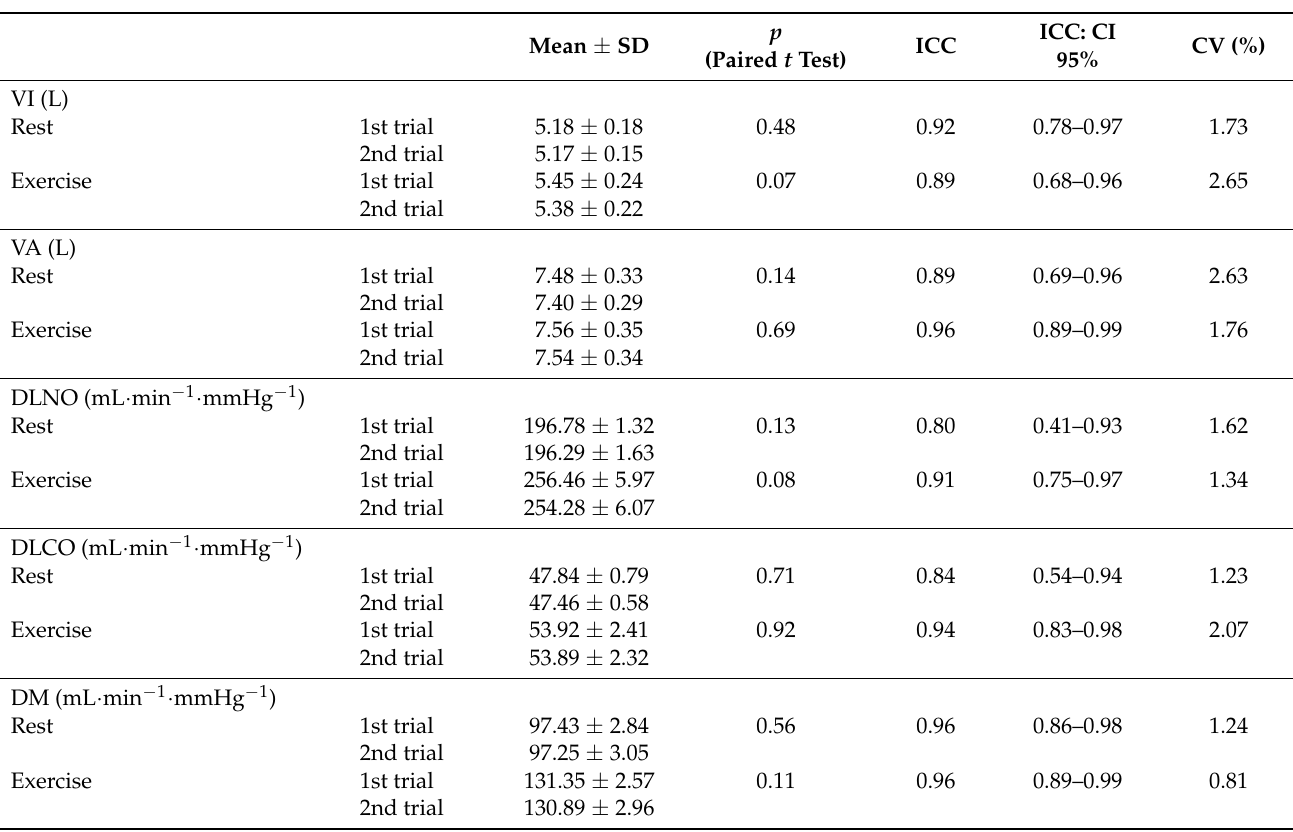
Table 3. Intraclass correlation coefficients (ICCs) for relative reliability and coefficients of variation for absolute reliability. Data are mean ± standard deviation (SD) of VI: inspiratory volume; VA: alveolar volume; TL NO : pulmonary diffusing capacity for nitric oxide; DL CO : pulmonary diffusing capacity for carbon monoxide; Dm: membrane component of alveolar– capillary transfer of gases; Vc: capillary blood volume. IET group: intense endurance training group; MET: moderate endurance training